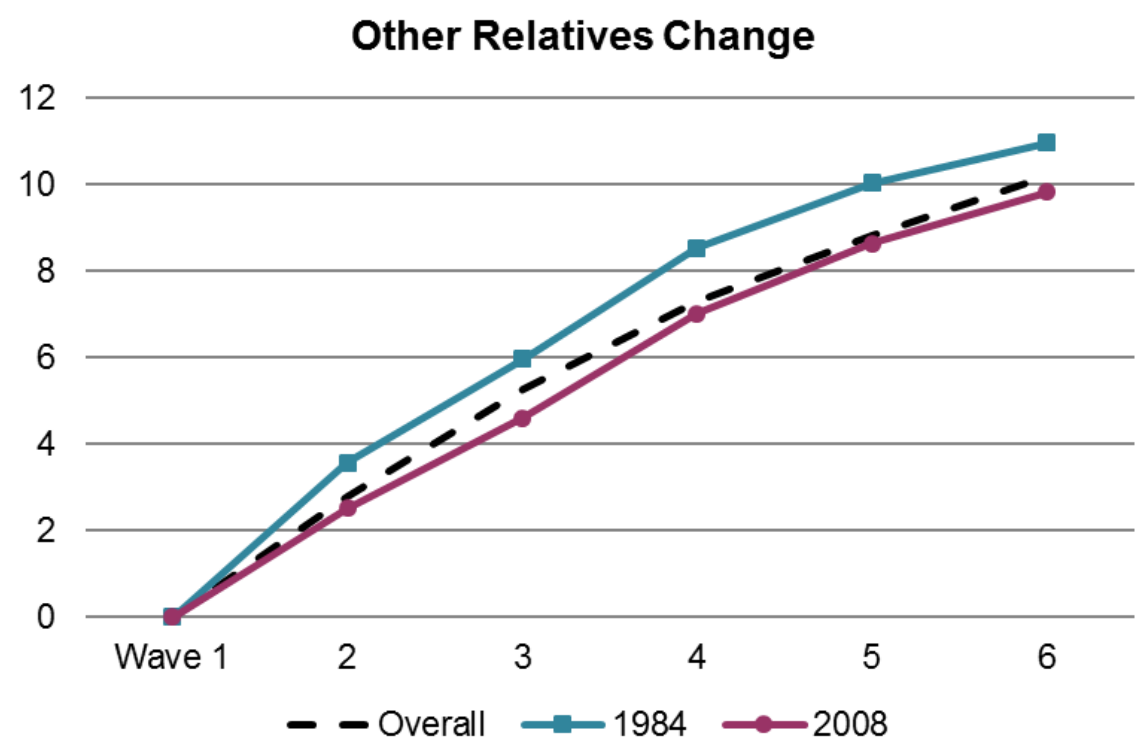
Figure 5: Weighted cumulative percent of children (by panel) exposed to other relatives leaving and joining